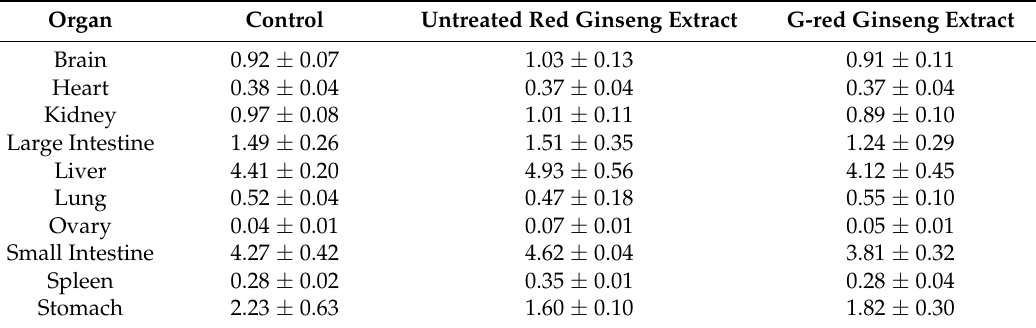
Figure 1. Changes in ( a ) body weight gain; ( b ) food intake; and ( c ) water consumption in rats administered G-red ginseng extract, untreated red ginseng extract, or distilled water (DW) as a control. Table 2. Organo-somatic indices of rats after 14-day repeated oral administration of G-red ginseng extract or untreated red ginseng extract.